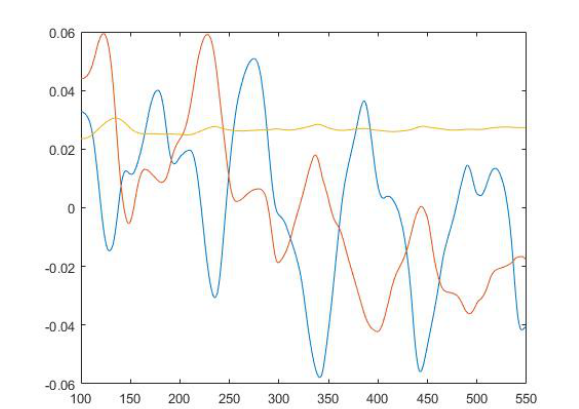
Fig. 29. The first three principal components for 50 cells in geometry C, seeding